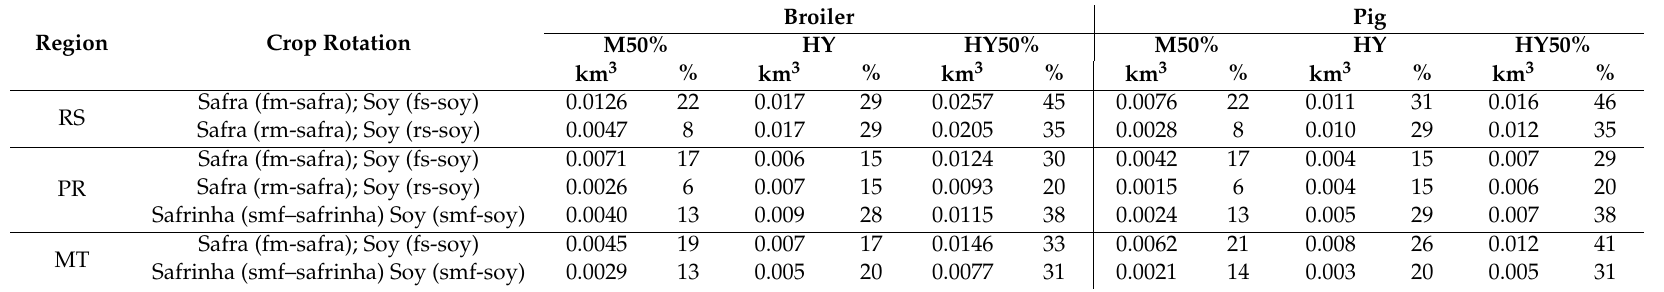
Table 5. Estimation of potential water saving (m 3 year − 1 ) for producing animal feed (Q indirect,Feed ) demanded to pigs and broilers. Region Crop